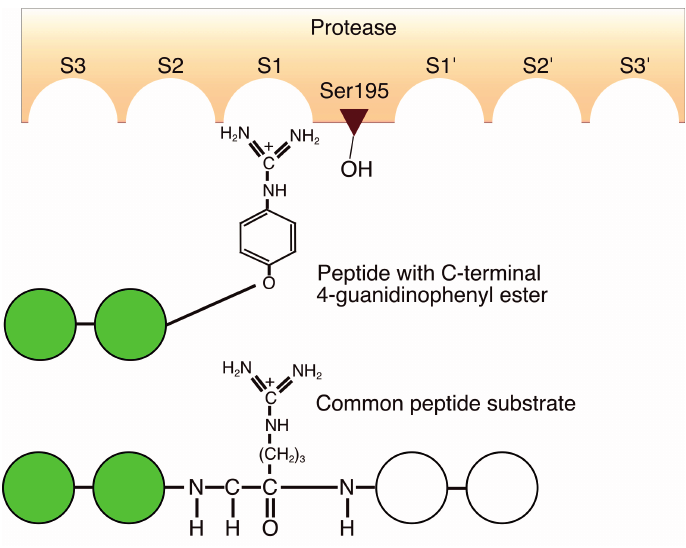
Figure 3. Schematic comparison of the binding of a peptide-4-guanidinophenyl ester and a common peptide substrate to the active site of trypsin based on the ideas of the conventional binding model of